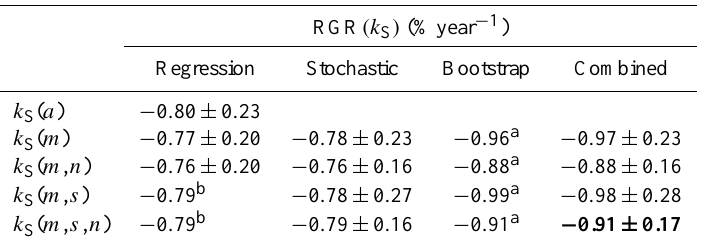
a,b See Table 1